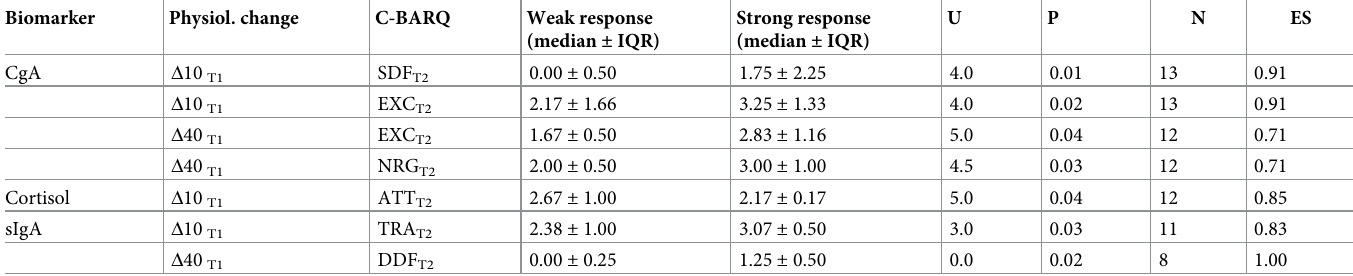
was associated with the desirable trait Trainability. In addition, slow recovery after the test ( Δ 40) was associated with low levels of Non-social fear and Touch sensitivity. Associations between physiological variables at T1 and behavior at T2 Ambiguous associations were found between puppies’ stress response, measured by levels of cortisol and CgA at T1, and their future behavioral traits (T2). Puppies with high physiological reactivity ( Δ 10) at T1 received higher scores at T2 for Stranger-directed fear, and Excitability (CgA) and lower scores for Attachment and attention-seeking (cortisol; Table 3). Those pup- pies with sustaining levels of CgA after the test ( Δ 40) received higher scores for Excitability and Energy level later in their life. Table 3. Significant differences in C-BARQ scores (owner ratings at T2) for puppies with small/large physiological changes in response to the behavioral test (Mann-Whitney U test). Biomarker Physiol.